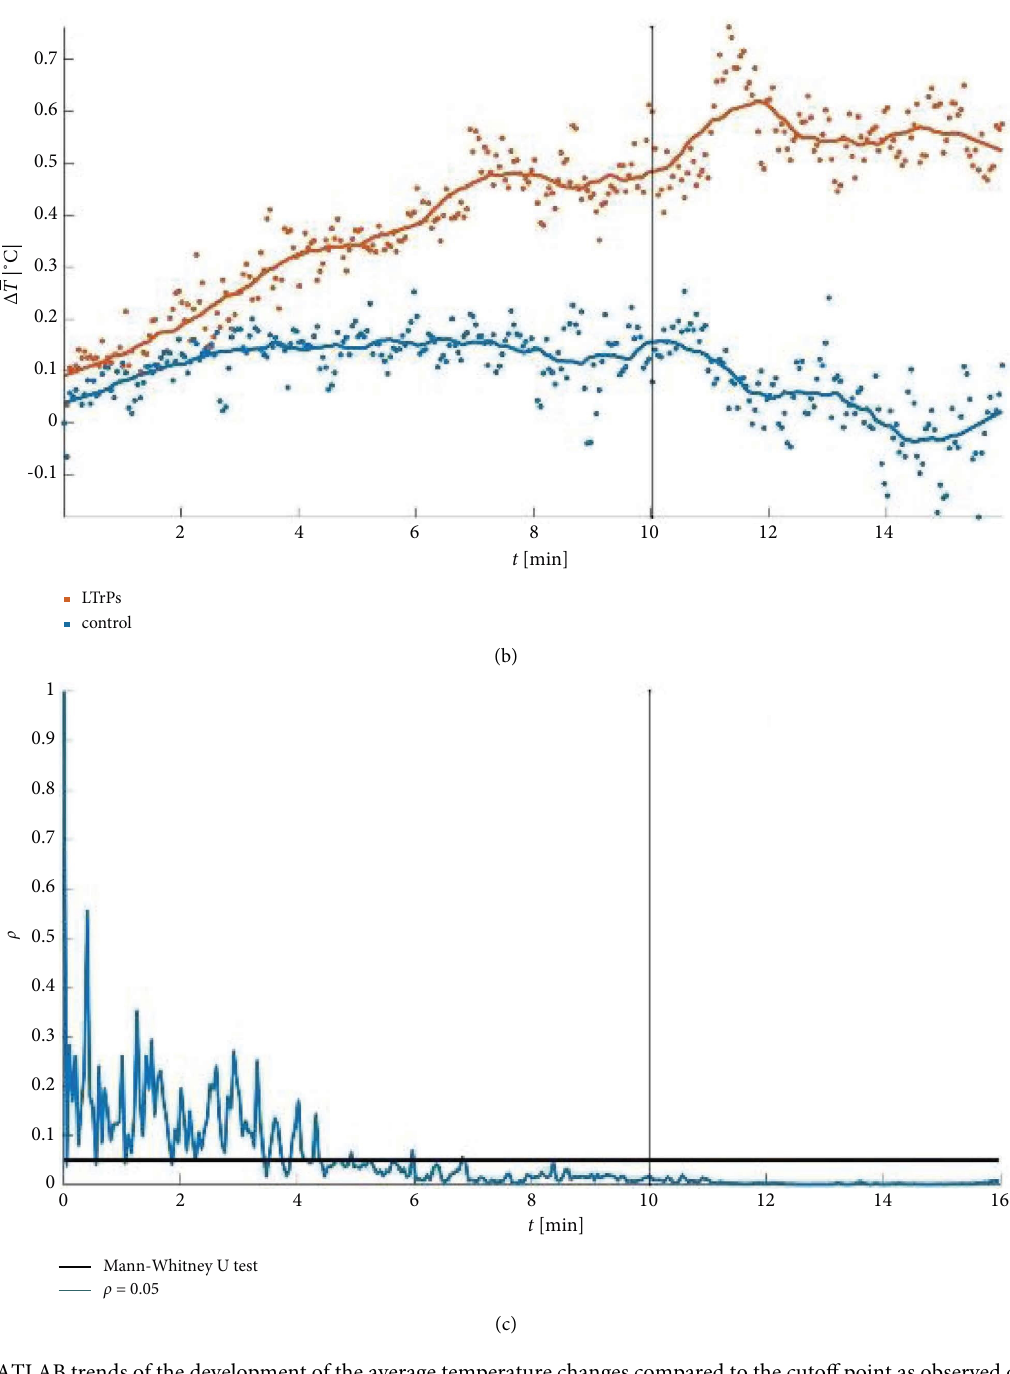
Figure 5: MATLAB trends of the development of the average temperature changes compared to the cutof point as observed during the SP test ® depend on the examined group and time of the procedure 4: (a) median value, (b) average value, and (c) Mann–Whitney U test results. Te control group was characterized by the temperature decrease, which confrmed the lack of abnormal autonomic phenomenon ∗ in this group ( ∗ the conditions of the positive the SP test ® for vasodilatation: (i) development of a new thermal subarea above the cutof; (ii) Δ T increase of more than 0.3 ° C as compared to the cutof